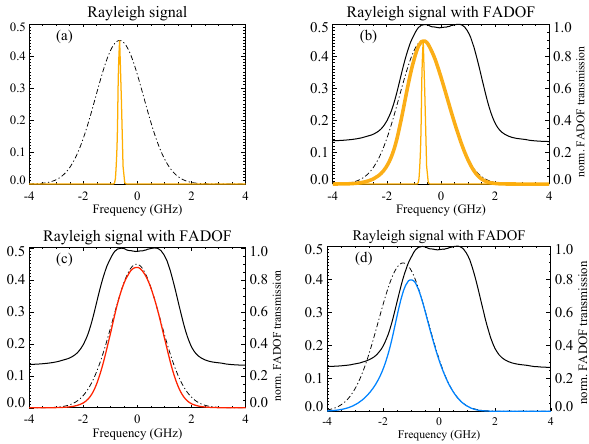
Fig. 2. The backscattered Rayleigh signal is doubly Doppler broad- ened. Figure 6a shows the line shape of the laser beam and the backscattered Rayleigh signal for 250K atmospheric temperature (dashed-dotted line). The FADOF reduces this signal as shown in (b) for the un-shifted beam (thick yellow line). In Figs. 6b–d also the normalised FADOF transmission is plotted (solid black line). The reduced backscattered Rayleigh signal of the up-shifted beam (red) and of the down-shifted beam (blue) are shown in (c) and (d) ,